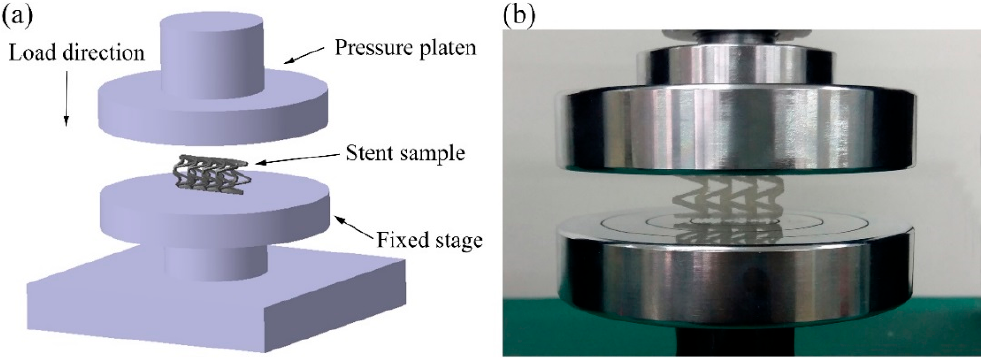
Figure 4. Compression experiment of PLA vascular stents, ( a ) the diagram of loading test setup; ( b ) stent sample in the test.